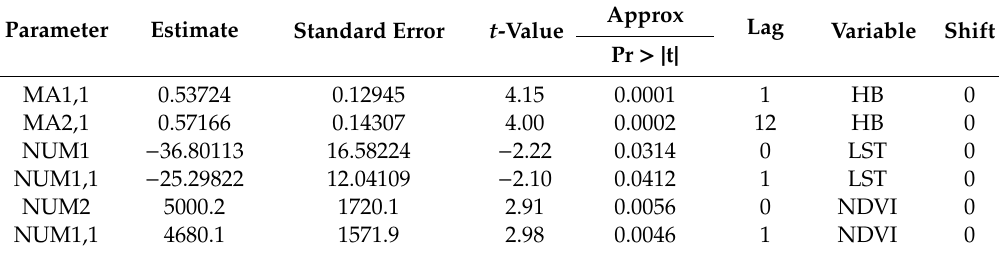
Table 3. Parameter significance test for HB by conditional least squares estimation.